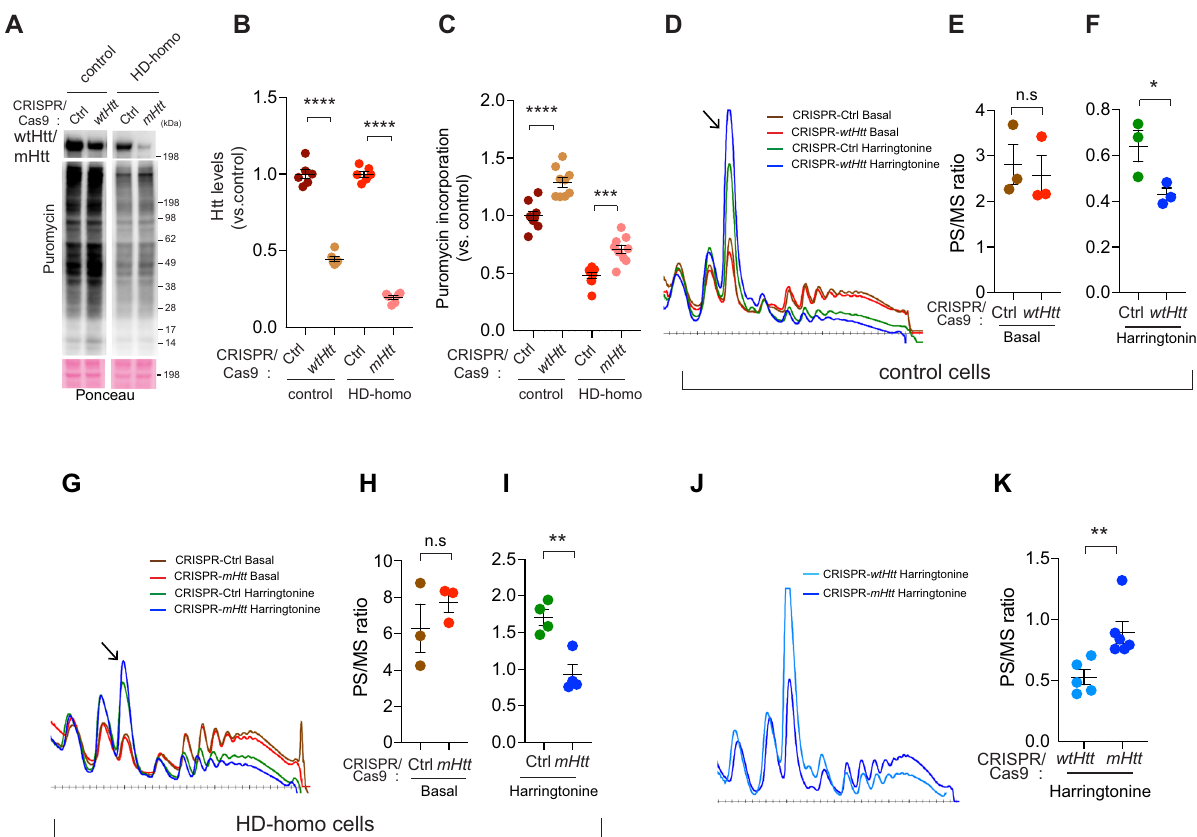
Fig. 2 Depletion of mHtt enhances protein synthesis and increases the speed of ribosome translocation. A Representative immunoblots performed on CRISPR/Cas9 Htt -depleted mouse striatal cells after puromycin metabolic labeling. B , C quanti fi cations of the blots from A showing levels of Htt ( B ), puromycin incorporation ( C ) in control (Ctrl) and Htt -depleted control, HD-homo striatal cells. Data are mean ± SEM ( n = 9 independent experiments), *** P < 0.001 and **** P < 0.0001 one-way ANOVA followed by Bonferroni ’ s multiple comparisons test. D – F Representative polysome pro fi les ( D ) obtained from wtHtt -depleted mouse striatal cells before (basal, E ) and after ribosome run-off assay using harringtonine (2 µ g/ml, 2 min, F ) and their corresponding quanti fi cation of polysome to monosome (PS/MS) ratios (area under the curve). Data are mean ± SEM ( n = 3 independent experiments), * P < 0.05 by two- tailed Student ’ s t test, n.s not signi fi cant. G – I Representative polysome pro fi les ( G ) obtained from mHtt -depleted mouse striatal cells before (basal, H ) and after ribosome run-off assay using harringtonine (2 min, I ) and their corresponding quanti fi cation of polysome to monosome (PS/MS) ratios (area under the curve). Data are mean ± SEM ( H , n = 3; I , n = 4 independent experiments), ** P < 0.01 by two-tailed Student ’ s t test, n.s not signi fi cant. J , K Representative polysome pro fi les ( J ) obtained from wtHtt - and mHtt -depleted mouse striatal cells after ribosome run-off assay using harringtonine (2 min), and their corresponding quanti fi cation of polysome to monosome (PS/MS) ratios ( K ). Data are mean ± SEM ( wtHtt depleted, n = 5; mHtt depleted, n = 6 independent experiments), ** P < 0.01 by two-tailed Student ’ s t test. n.s not signi fi cant. Exact P values are reported in the Source Data fi le. Source data are provided as a Source Data fi